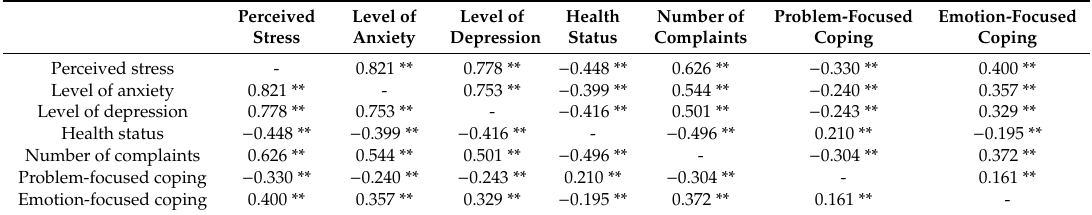
Table 4. Significant correlations between psychological factors’ scores of Hungarian adults ( n =